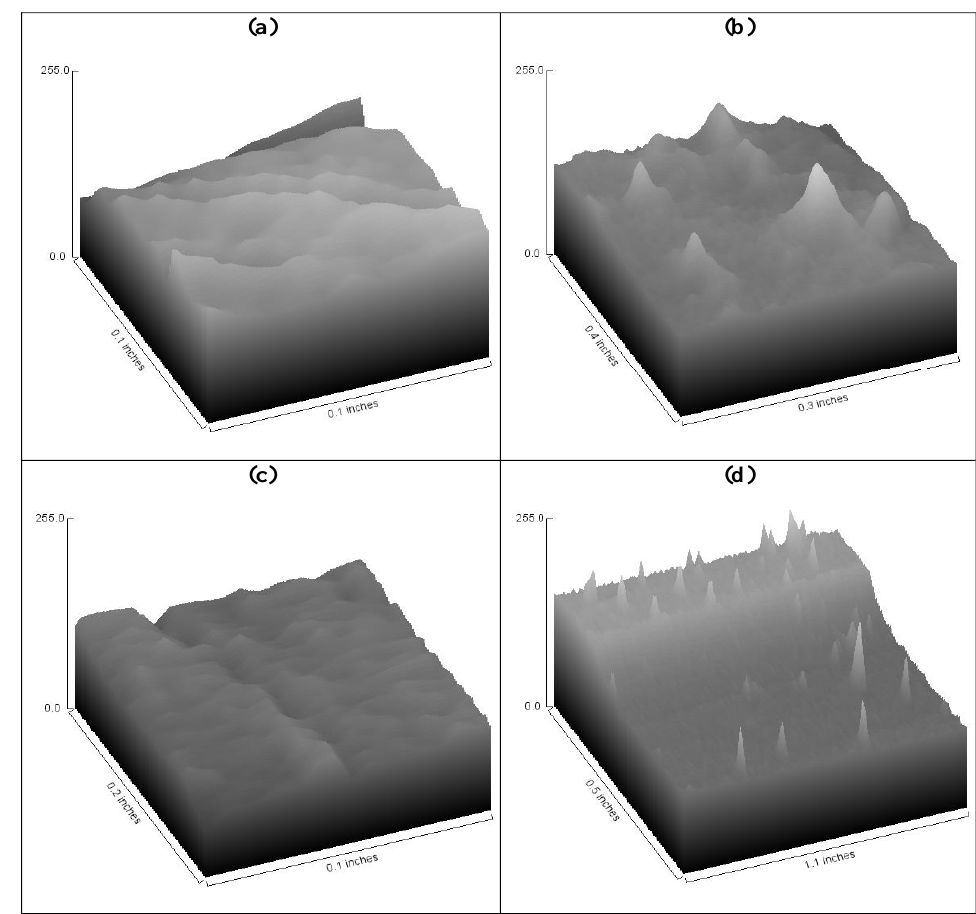
Figure 4. Surface morphological plot of CO ( a ), Co—G ( b ), P—PET ( c ), and P—PET—G ( d ).